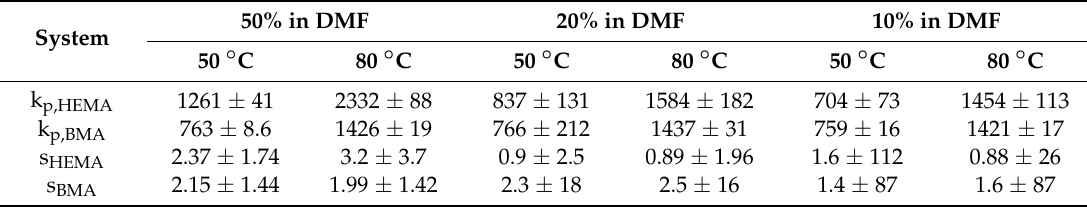
Table 5. Homopropagation k p values (L/mol s) and radical reactivity ratios (with 95% confidence intervals) estimated by fitting of the IPUE model to BMA/HEMA k p,cop data measured in DMF solution at 50 and 80 ◦ C, with monomer reactivity ratios for each system taken from Table 2. Percentage